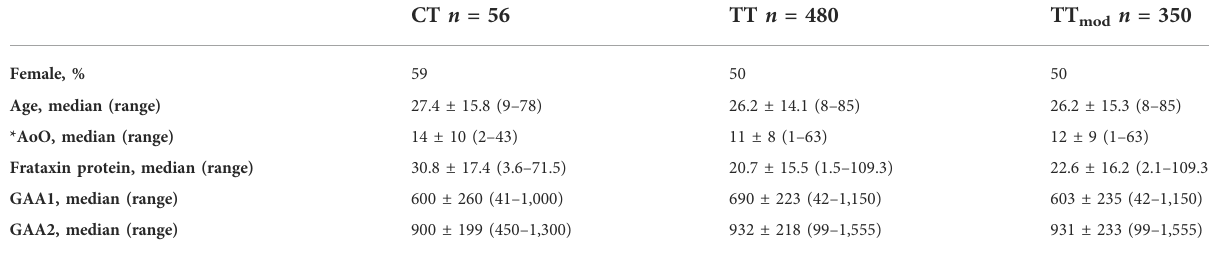
TABLE2Patientdemographics.TT mod wascreatedtoaccountforthedifferenceinGAA1lengthbetweenCTandTTbyrandomlyremovingsubjectsin the TT group with GAA1 length above the median until the GAA1 of TT mod was within10 triplets of CT.Age and age of onset (AoO) are reported in years.Frataxinproteinlevelswerereportedas%ofnon-FRDAhealthycontrols(controlsconsistofacollectionof5 – 10peoplewhodonothaveFRDA and are not carriers of the GAA-TR expansion. These controls were sampled repeatedly and run alongside patient samples in the same assay). GAA1 and GAA2 were reported as the number of triplets. Values are reported at median±standard deviation with the range of values in parentheses. Medians were compared with the Mann – Whitney test. *AoO showed p = 0.02 for CT vs. TT, all other variables were not signi fi